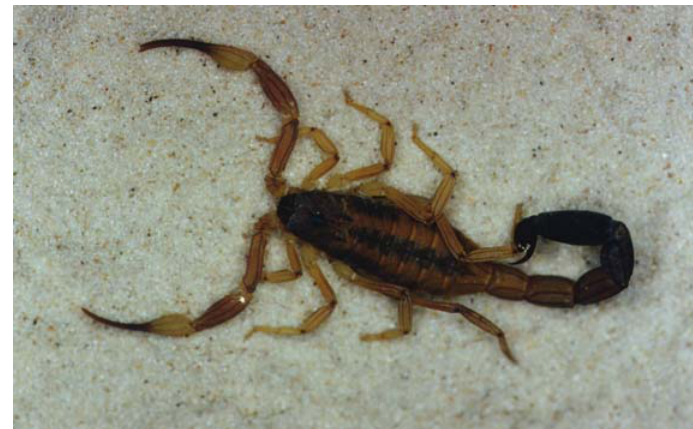
Figure 6. Female of Tityus trivittatus .